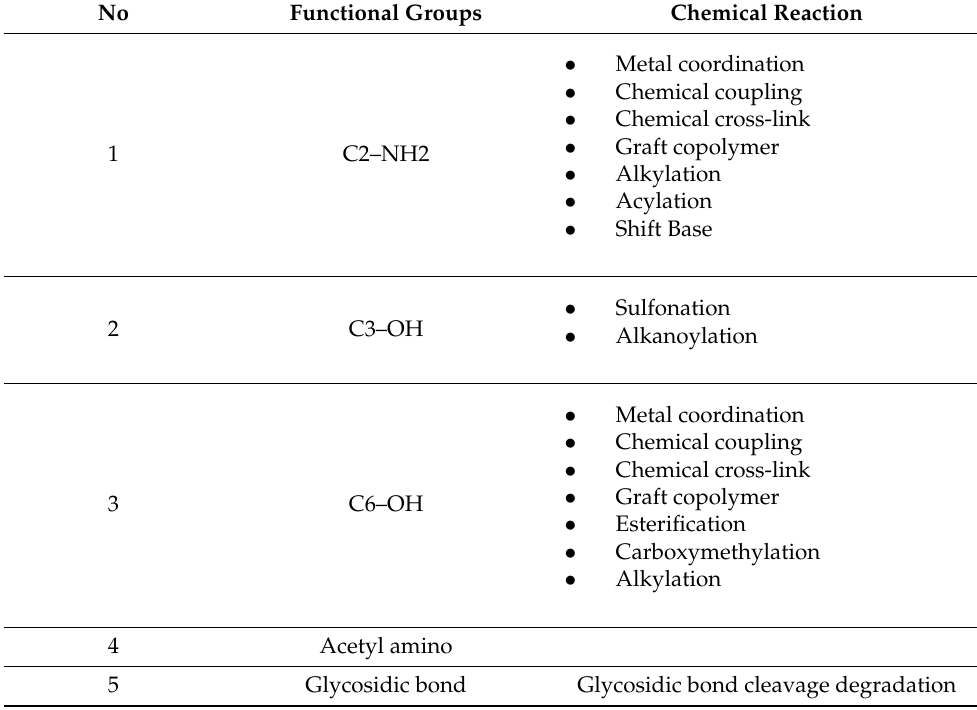
Table 1. Functional groups of chitosan chemical